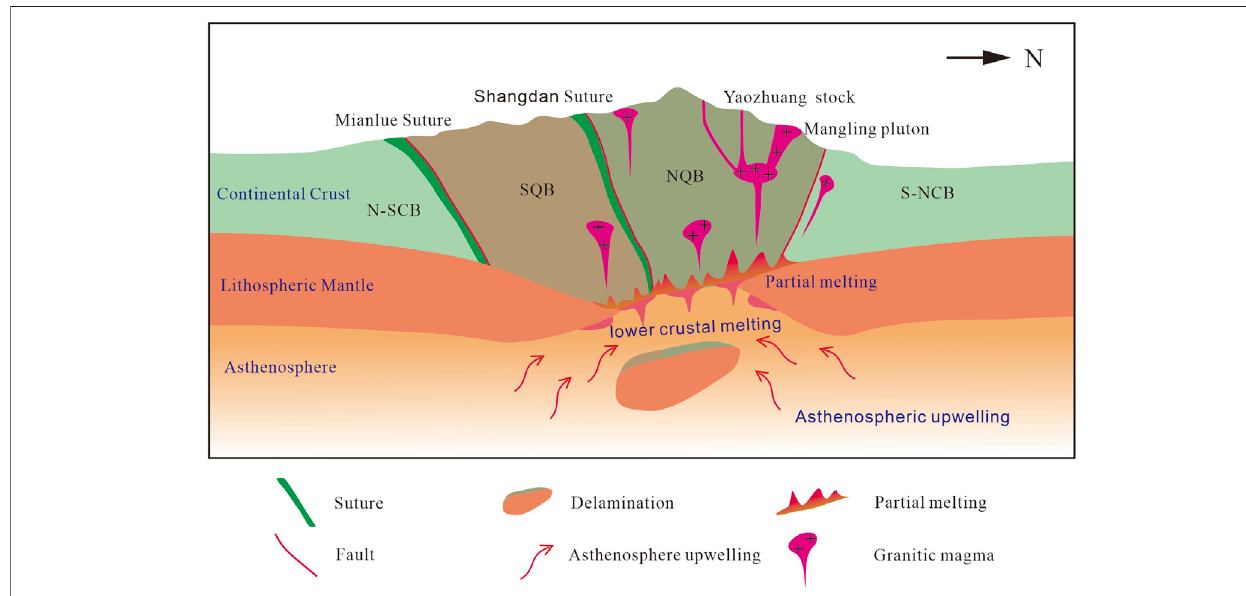
FIGURE 10 | Tectonic magmatic model map of the North Qinling.